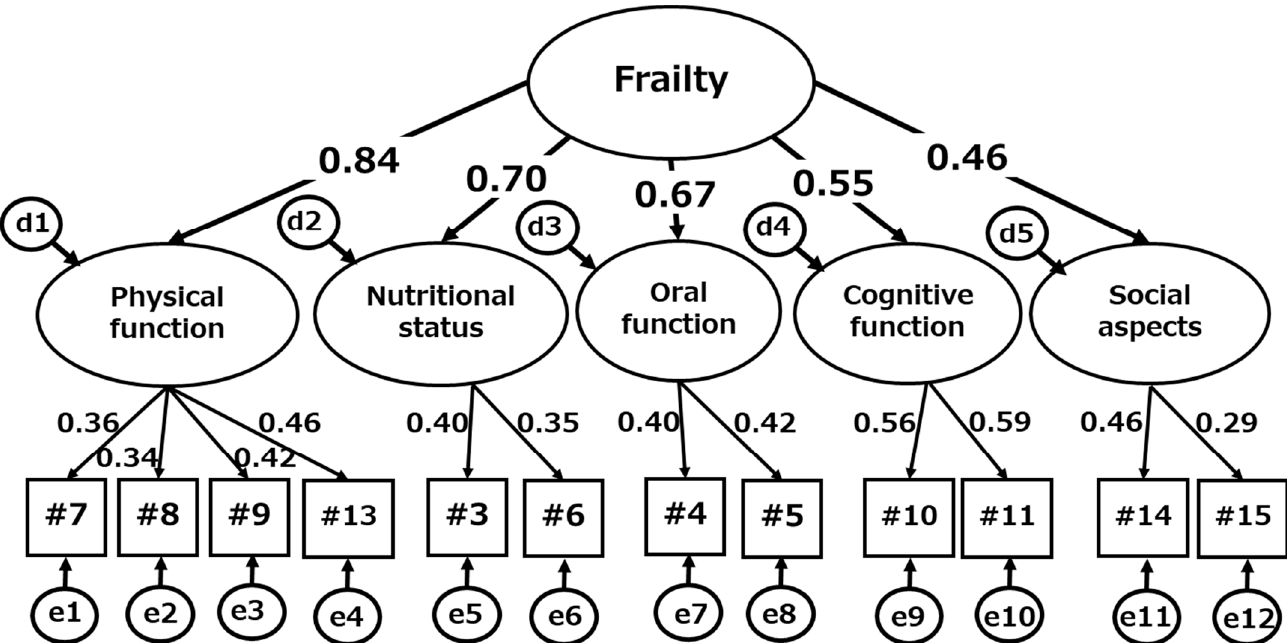
Figure 2. Factor structure and loadings on the 12 frailty-related items of the health assessment questionnaire for old-old adults in the CFA using SEM. χ 2 (49) = 156.2 ( p < 0.001), GFI = 0.983, AGFI = 0.973, RMSEA = 0.037, AIC = 214.2. All factor loadings were statistically significant ( p < 0.05). #3 eating habits; #4 masticatory function; #5 swallowing function; #6 weight loss; #7 walking speed; #8 experiences of falls; #9 exercise habits; #10 memory loss; #11 date disorientation; #13 going out; #14 interaction with others; and #15 health-related